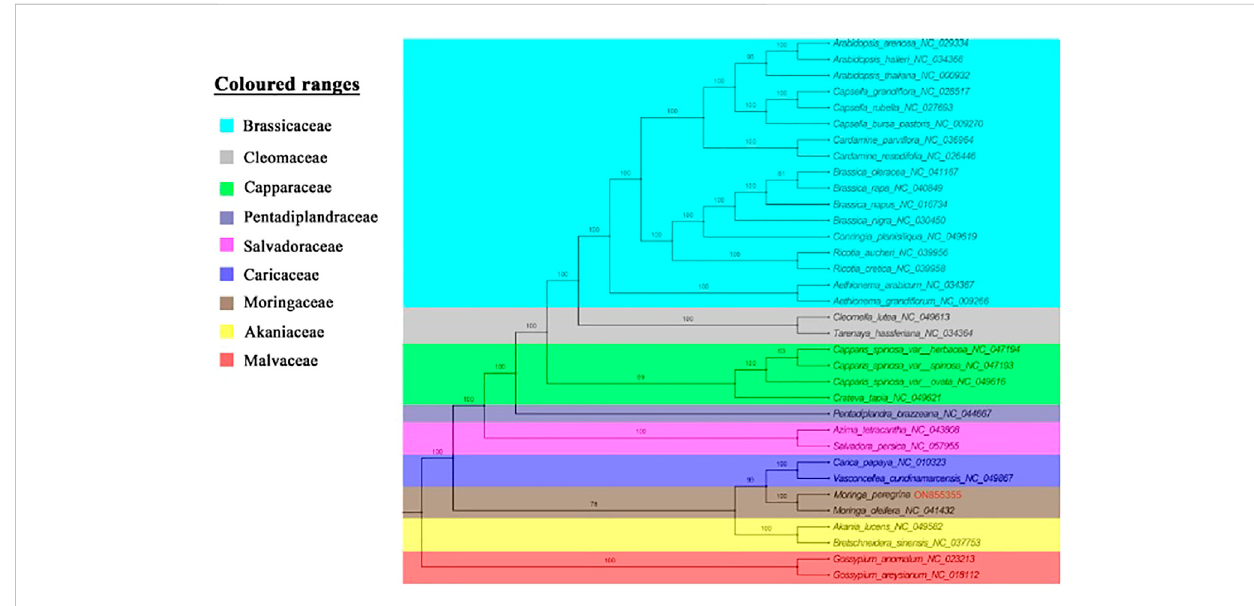
FIGURE 7 Phylogenetic topology for 34 complete plastome of Brassicales order species and two outgroups depend on 54 protein-coding genes among all plastome structures, used maximum likelihood analysis with bootstrap estimated